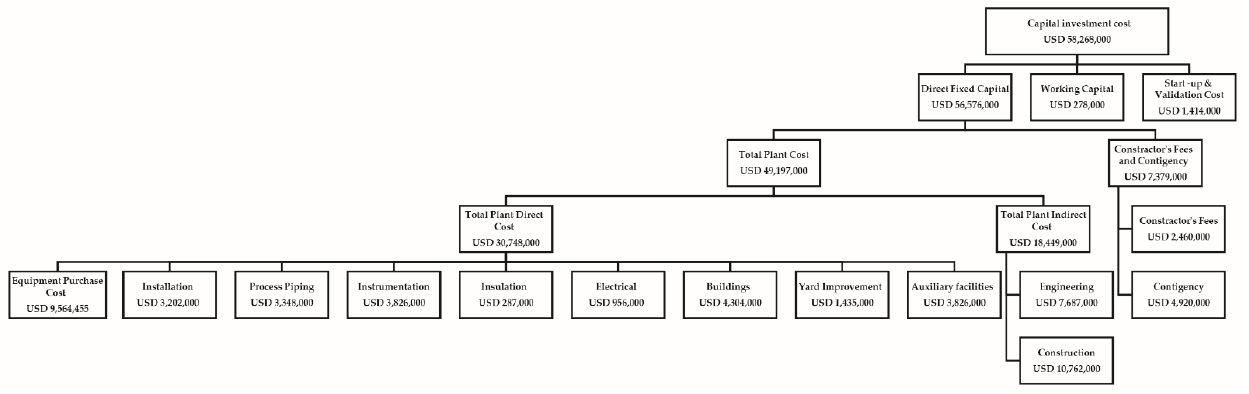
Figure 4. Detailed breakdown of the capital investment costs for the bioethanol-production plant from spent sugar beet pulp.